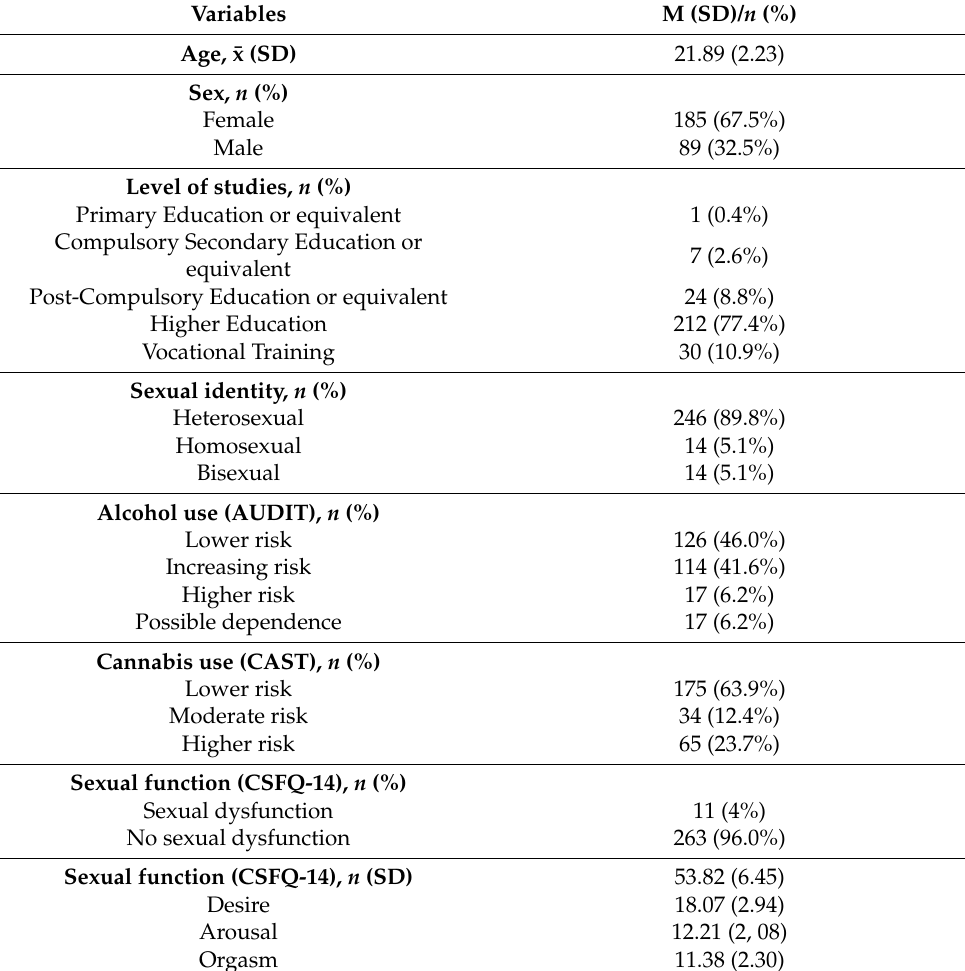
Table 2. Sociodemographic characteristics of the participants.